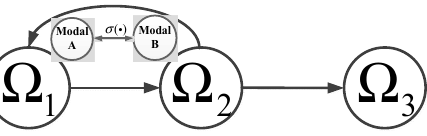
Figure 7. Zone transfer using mimicry strategy when under attack.